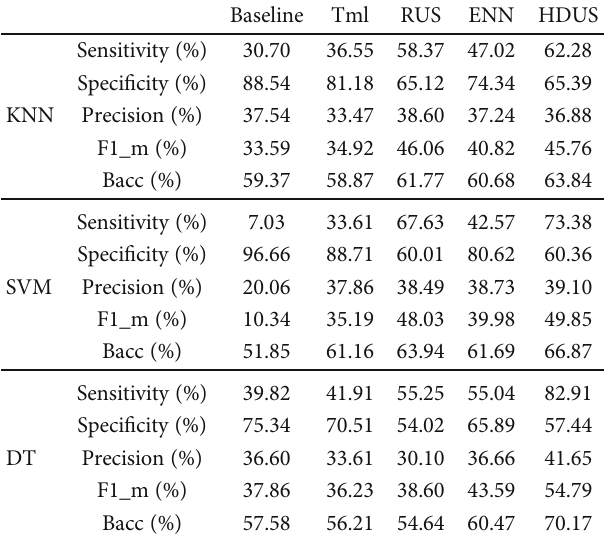
Figure 3: The average Bacc results using models (baseline, Tml, RUS, ENN, and HDUS) for four datasets. Table 9: The average results using classi fi ers (KNN, SVM, and DT) with models (baseline, Tml, RUS, ENN, and HDUS) on four